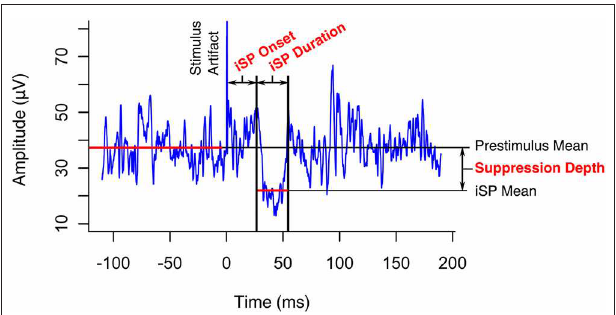
FIGURE 3 | Transcallosal inhibition (TCI) of voluntary hand contraction was elicited by transcranial magnetic stimulation of the ipsilateral motor representation of the hand. The ipsilateral silent period (iSP) was identified on the resulting electromyogram as a transient inhibition of voluntary activity and its onset, duration, and depth were quantified as